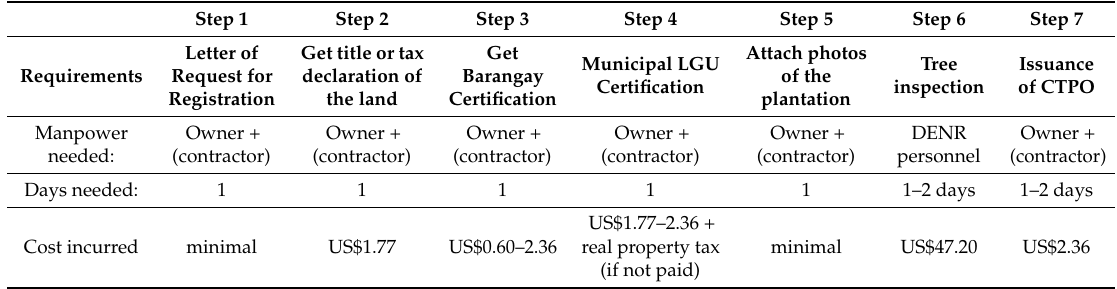
Table 4. Steps in securing the certificate of tree plantation